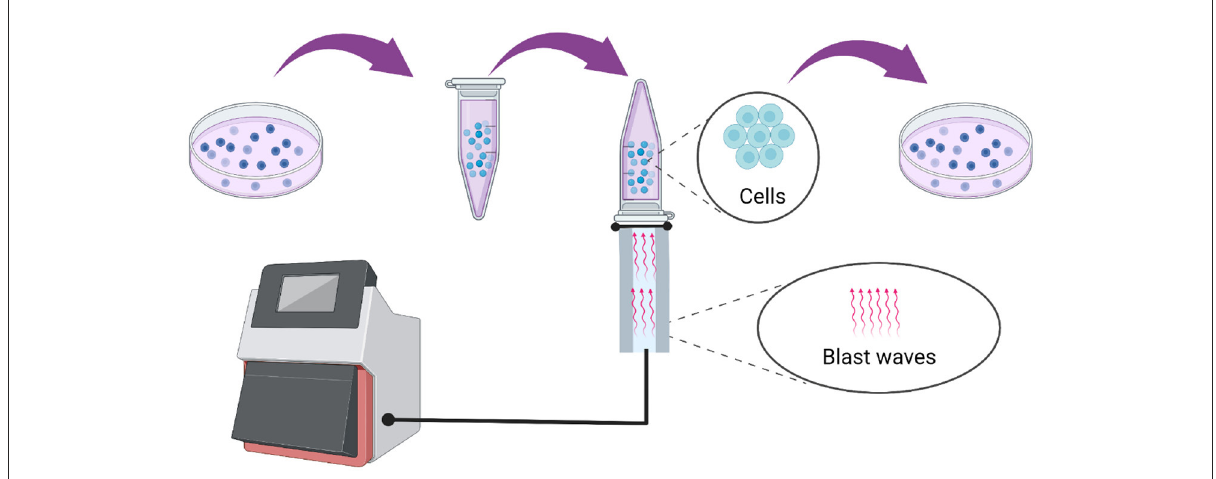
FIGURE1 Model construction process using a blast wave therapy instrument type HM08CJ based on the alveolar epithelial